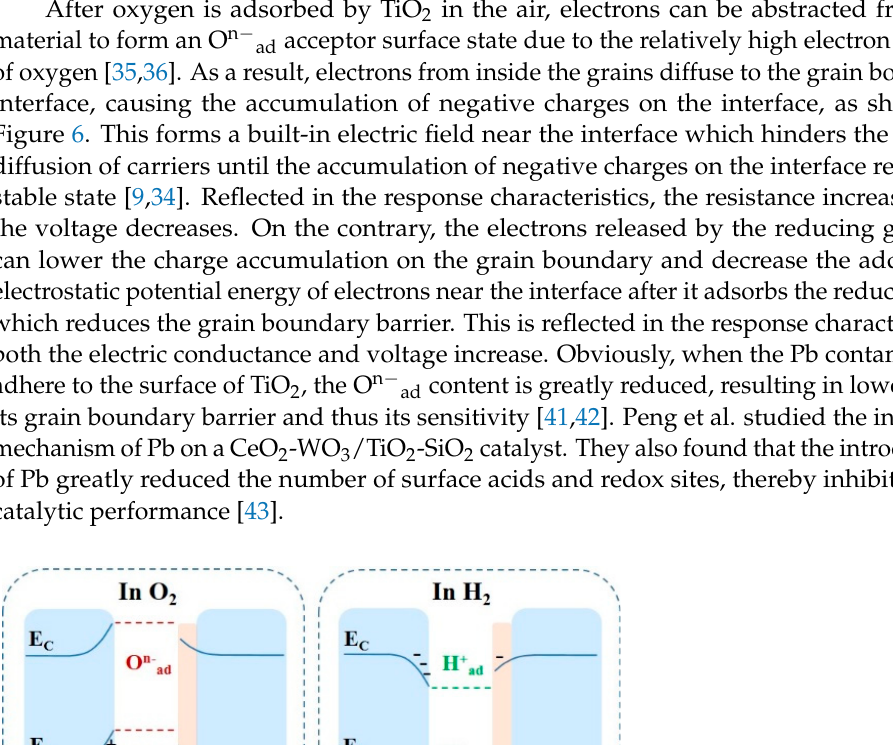
Figure 5. Response characteristics of TiO 2 and Pb-TiO 2 in H 2 ( A ) and O 2 ( B ) atmosphere.